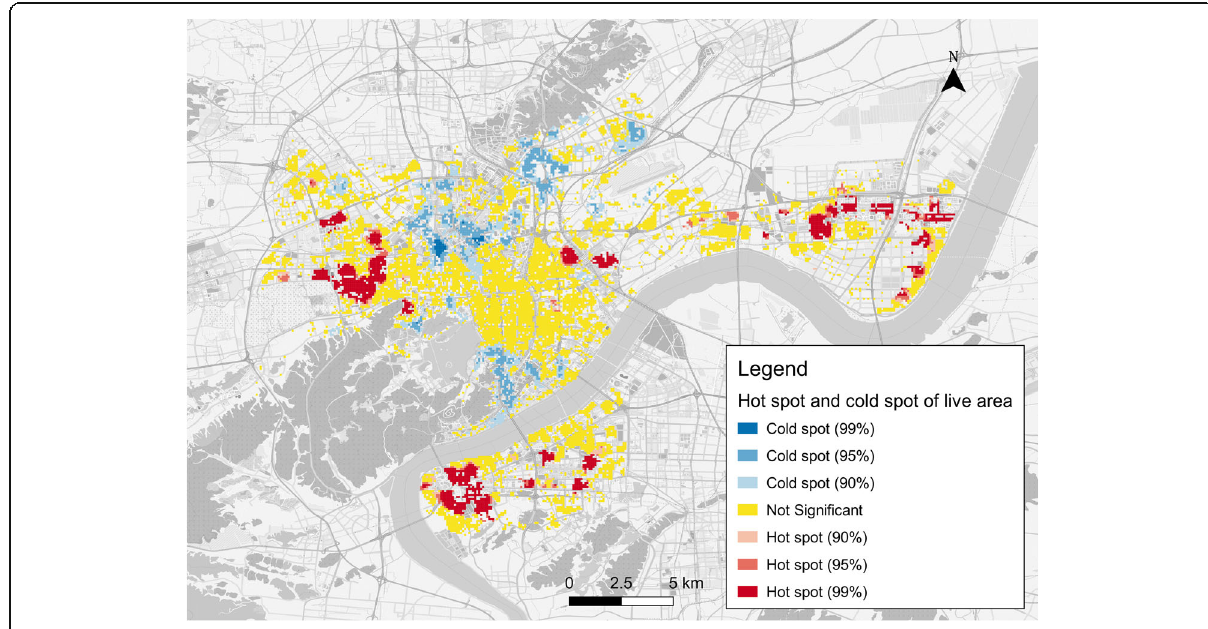
Fig. 10 Hot spot and cold spot of live area in the study area